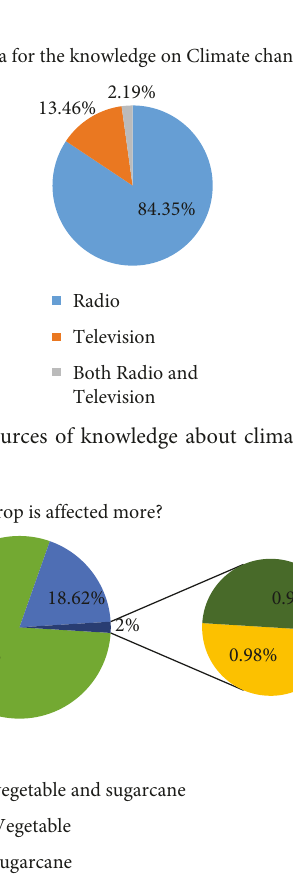
Figure 3: Knowledge about climate change.